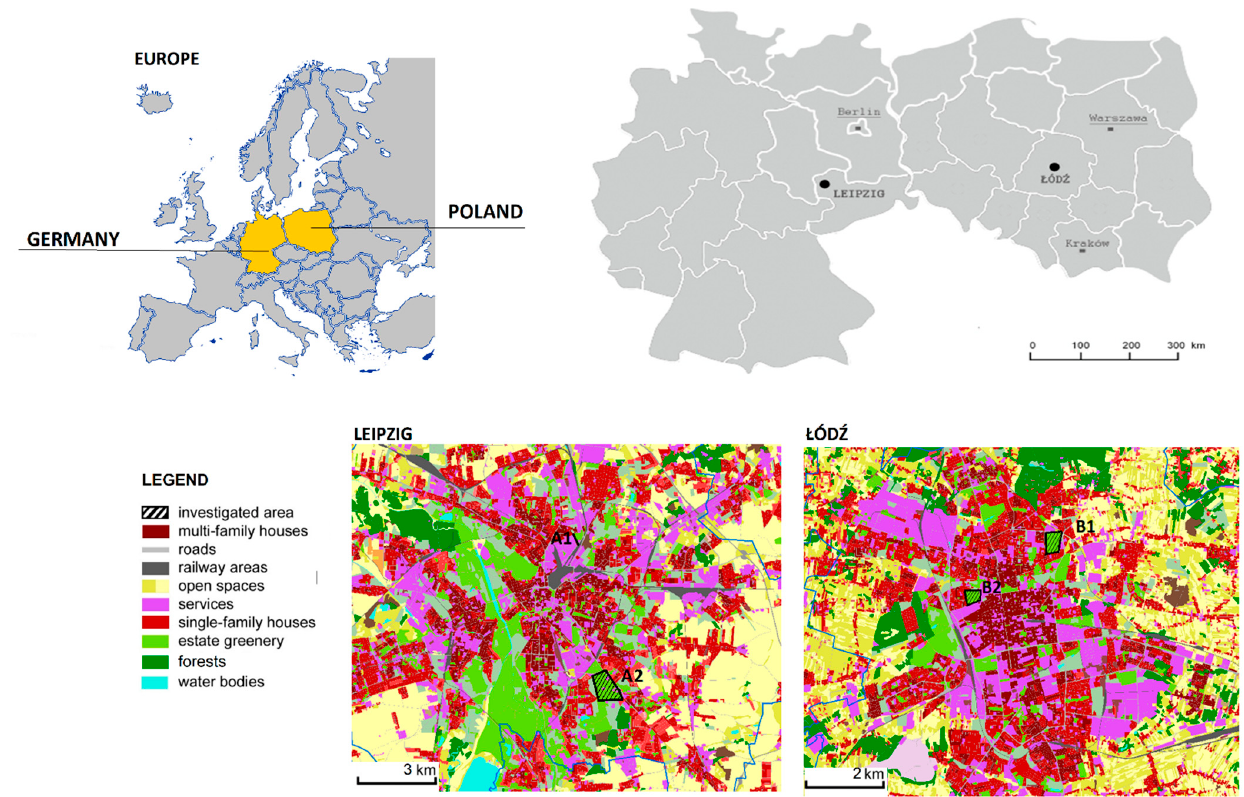
Figure 2. Study areas and site locations in Leipzig, Germany (A1 and A2) and Ł ód ź , Poland (B1